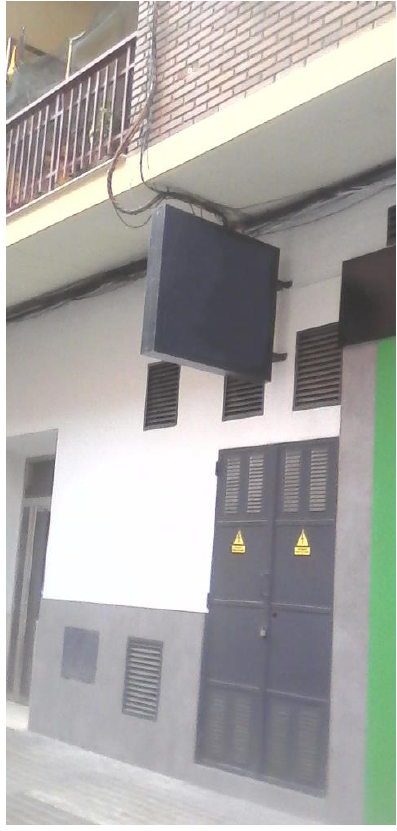
Figure 9. Location of the studied distribution transformer substation (DTS) in a building.